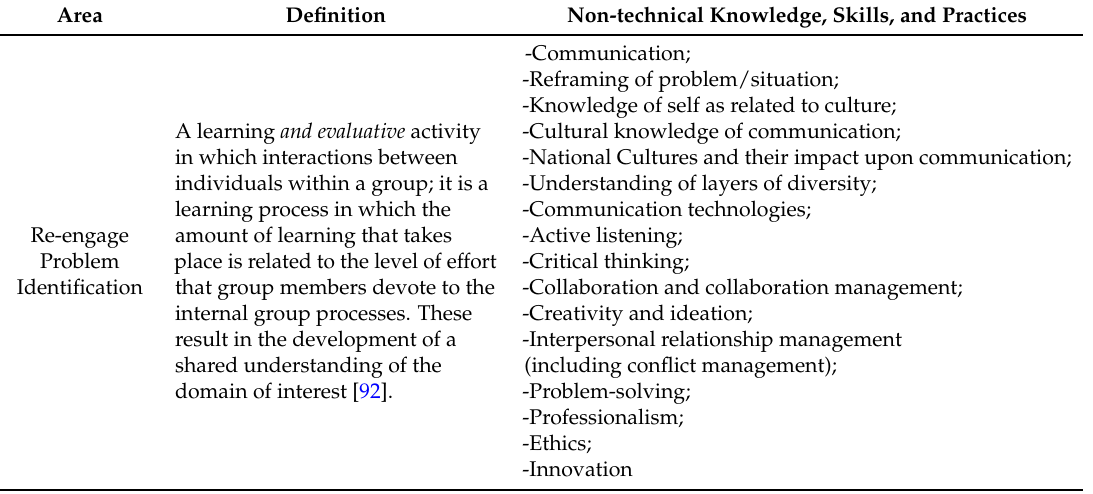
Table 6. Typology of non-technical skills necessary for step 4: evaluation and interpretation: re-engagement of problem identification